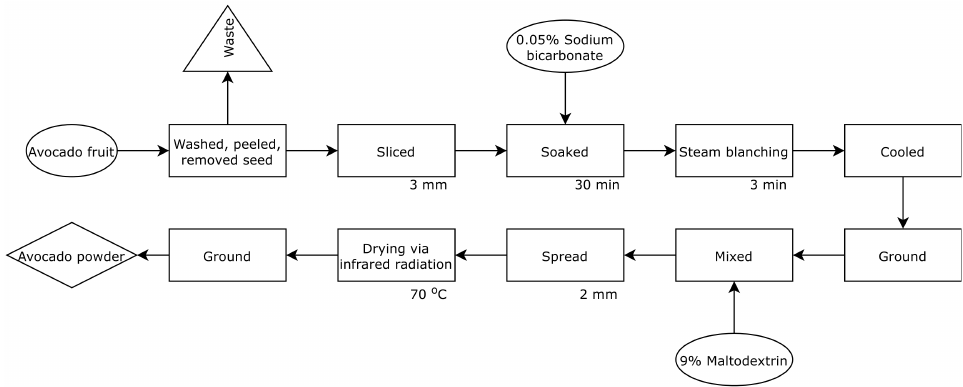
Figure 6. Flowchart showing avocado powder